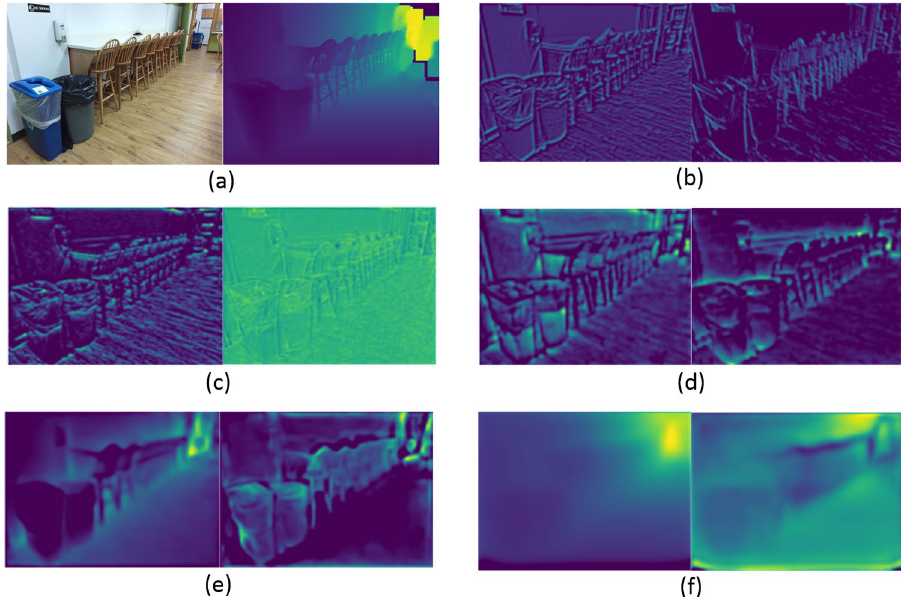
Figure 5. Visualization of decoded features. ( a ) RGB image and the ground truth. ( b ) Several channels in ( b ) features1 , ( c ) features2 , ( d ) features3 , ( e ) features4 , and ( f ) features5 .